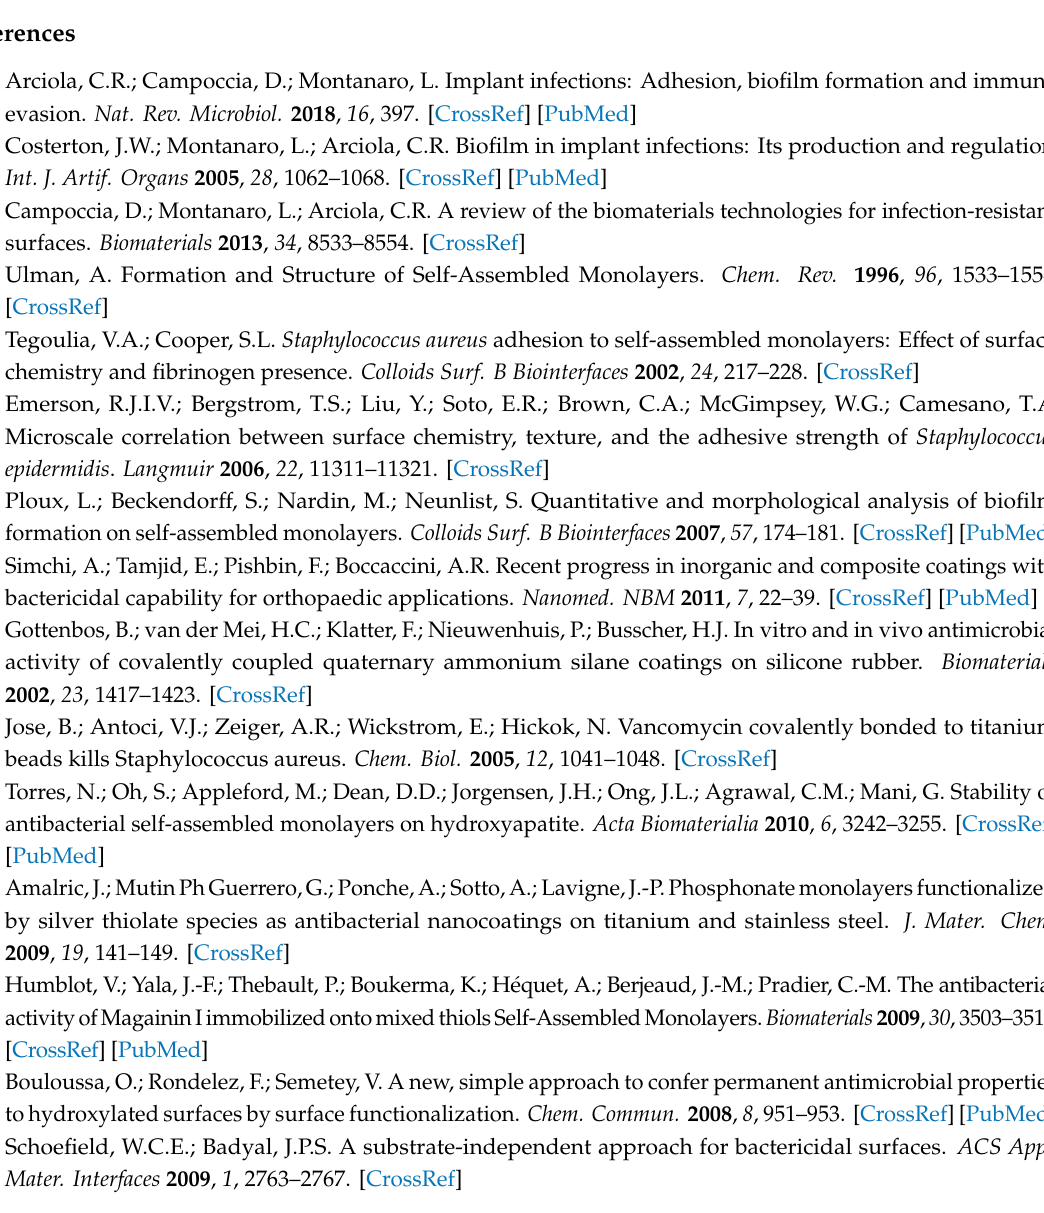
Figure S1. Spectroscopic Ellipsometry. Figure S2. Sulfadiazine maleimide (SDM) PM3 model. Figure S3. NMR spectra of SDMA (with enlarged zone of characteristic protons). Figure S4. NMR Spectra for SDM and AgSDM (with enlarged zone of characteristic